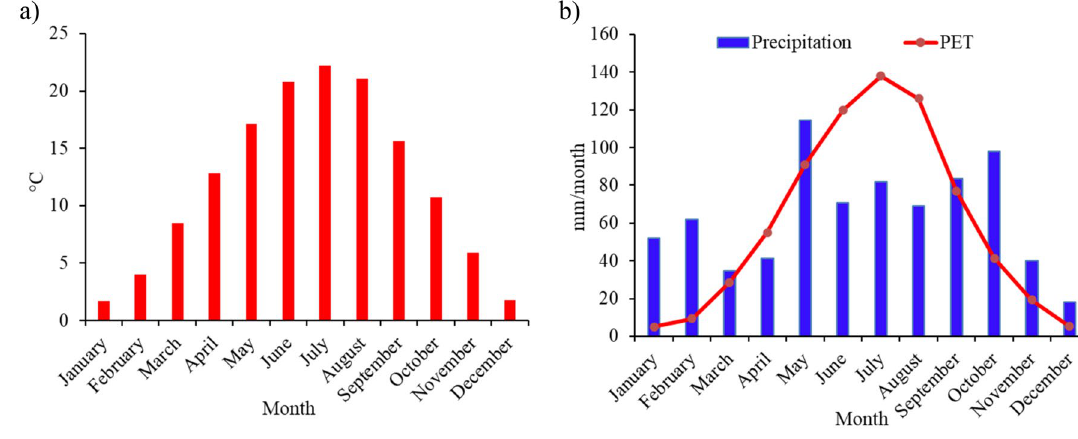
Figure 2. Long-term average monthly (1981–2018): ( a ) air temperature; ( b ) precipitation and potential evapotranspiration.